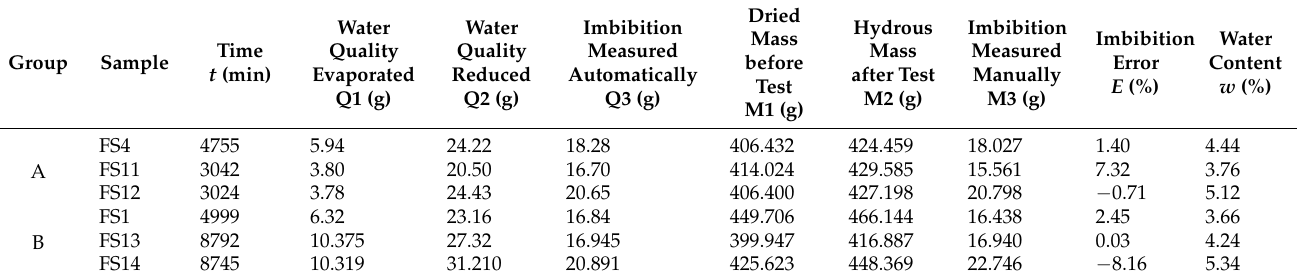
Table 5. Results of imbibition test without water pressure.